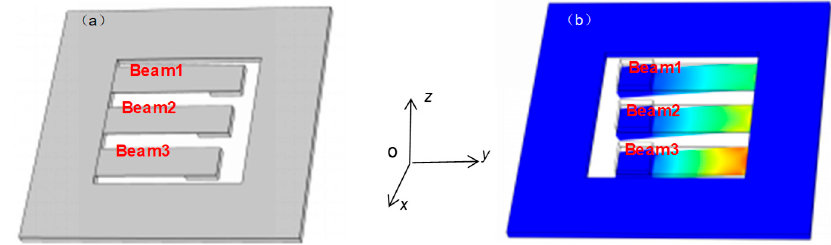
Figure 2. The operating principle of the energy harvester: ( a ) without environmental vibration; ( b ) under environmental